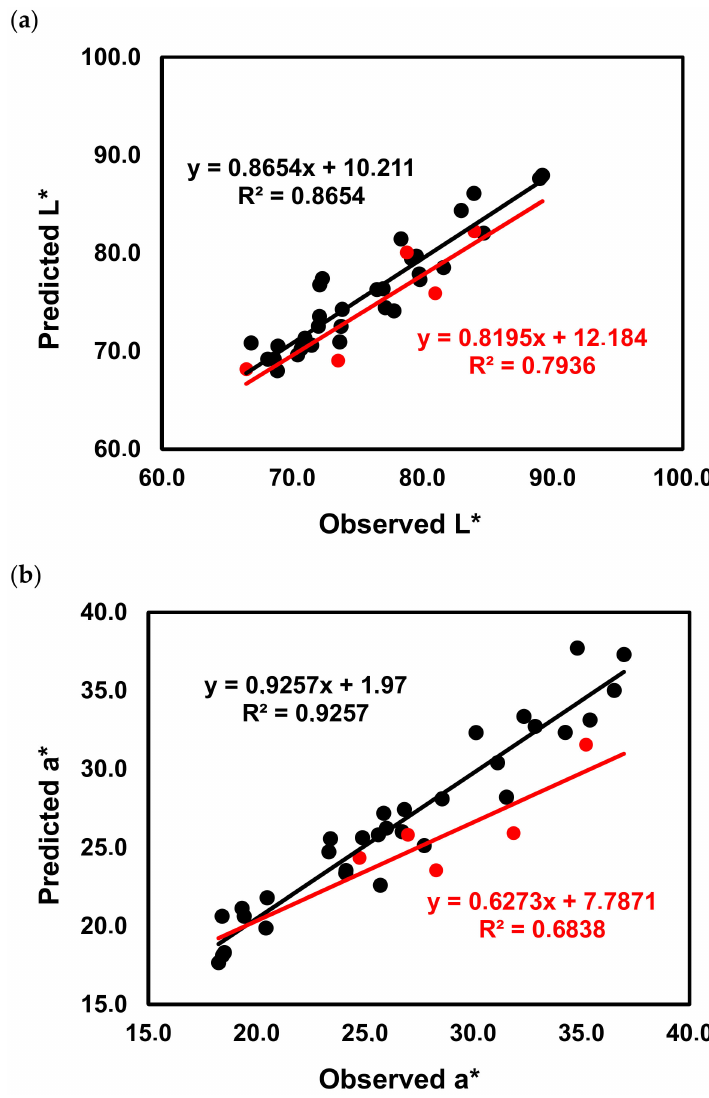
Figure 7. Calibration curves were obtained after Partial Least Squares (PLS) regression of the L* values ( a ) and of the a* values ( b ) of ‘Menc í a’ / ‘Jaen’ wines using the phenolic composition as independent variables. Black circles calibration samples, red circles test